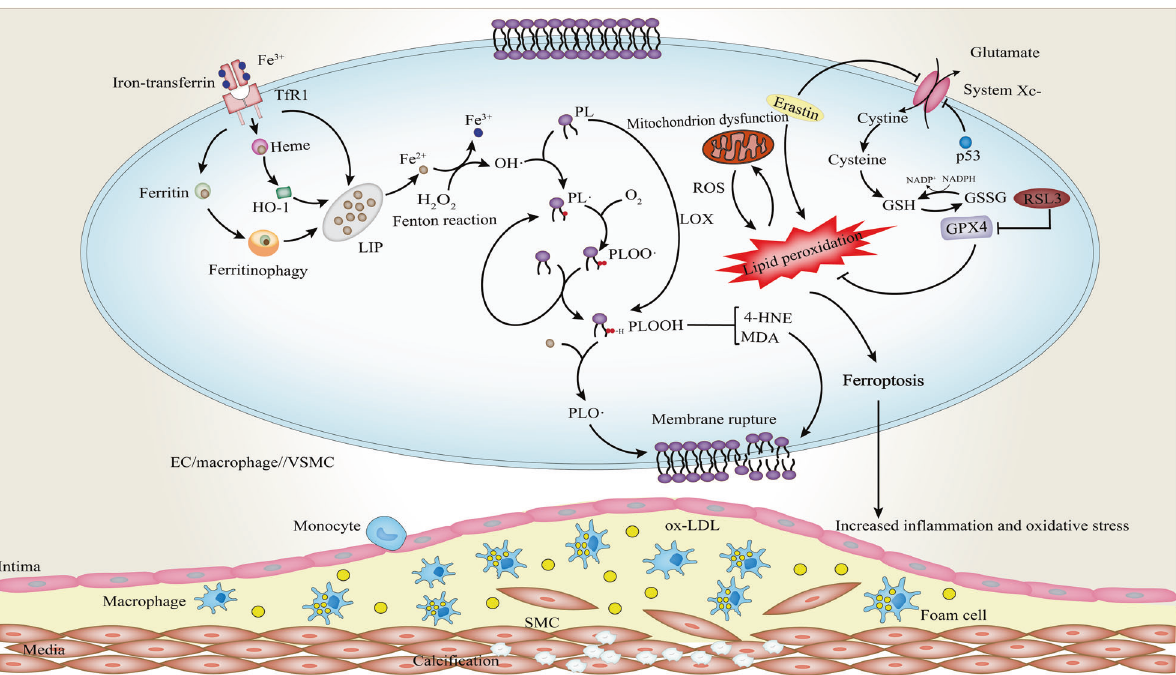
Fig. 5 Ferroptotic signaling in AS and VC. Iron-dependent phospholipid peroxidation and reduced antioxidant capacity lead to cell death. Fe 2 + provided by the labile iron pool (LIP) reacts with hydrogen peroxide (H 2 O 2 ) to form the hydroxyl radical (OH·) through Fentons reaction. new (PL·), initiating another lipid radical chain reaction. In enzymatic lipid peroxidation, the generation of PLOOH results from the dioxygenation of PUFAs by lipoxygenases (LOX). PLOOH in the presence of Fe 2 + can be converted to the alkoxyl phospholipid radical (PLO·),